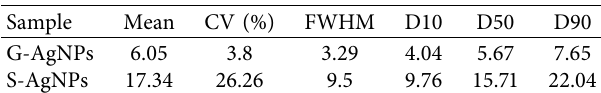
Figure 3: TEM micrograph of silver nanoparticles. (a) AgNPs obtained by “green” synthesis. (b) AgNPs obtained by the nongreen method. Differential size distribution of (c) G-AgNPs and (d) S-AgNPs. Table 1: Size distribution statistical parameters of silver nano- particles in